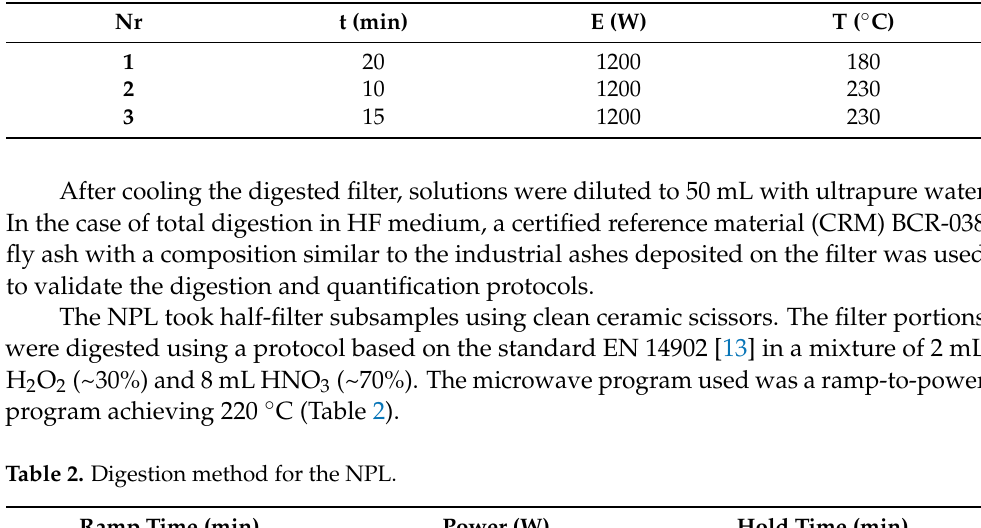
Table 1. Digestion method for LNE.